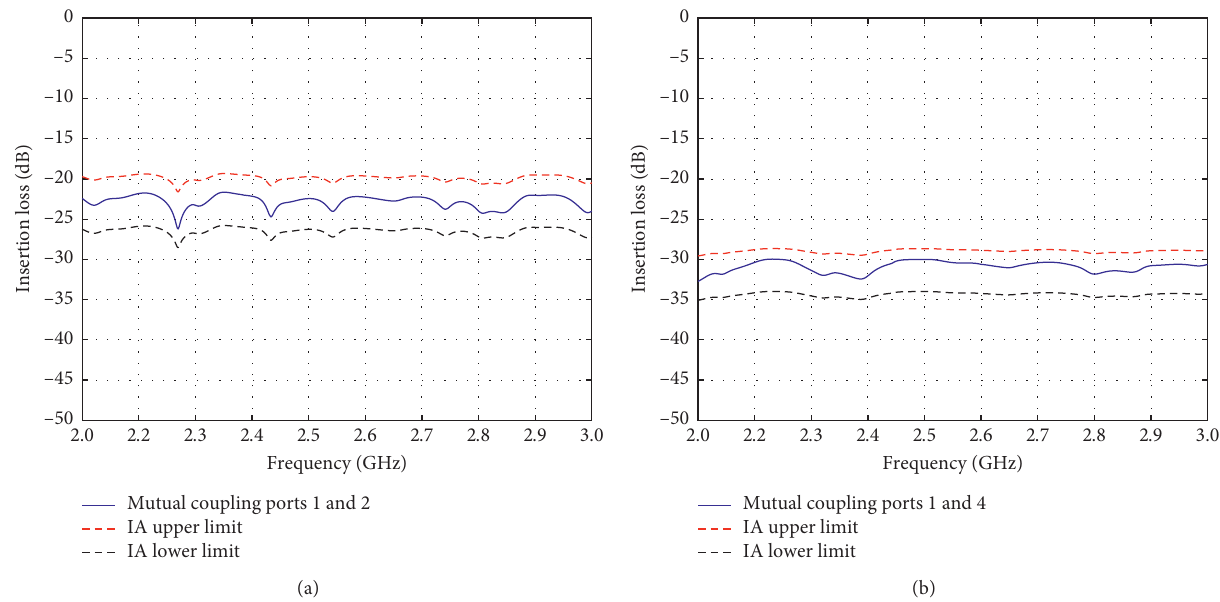
Figure 6: S-band Rotman lens: coupling factor vs. frequency (a) between ports P1 and P2 and (b) between ports P1 and